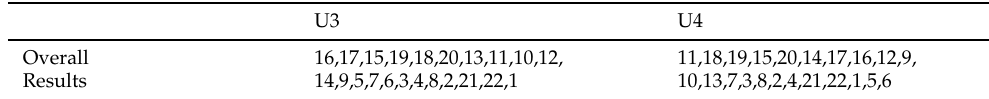
Table 7 demonstrates the ranking of U3 and U4 values in terms of configuration numbers. Table 7. Ranking of Utility Values for Overall